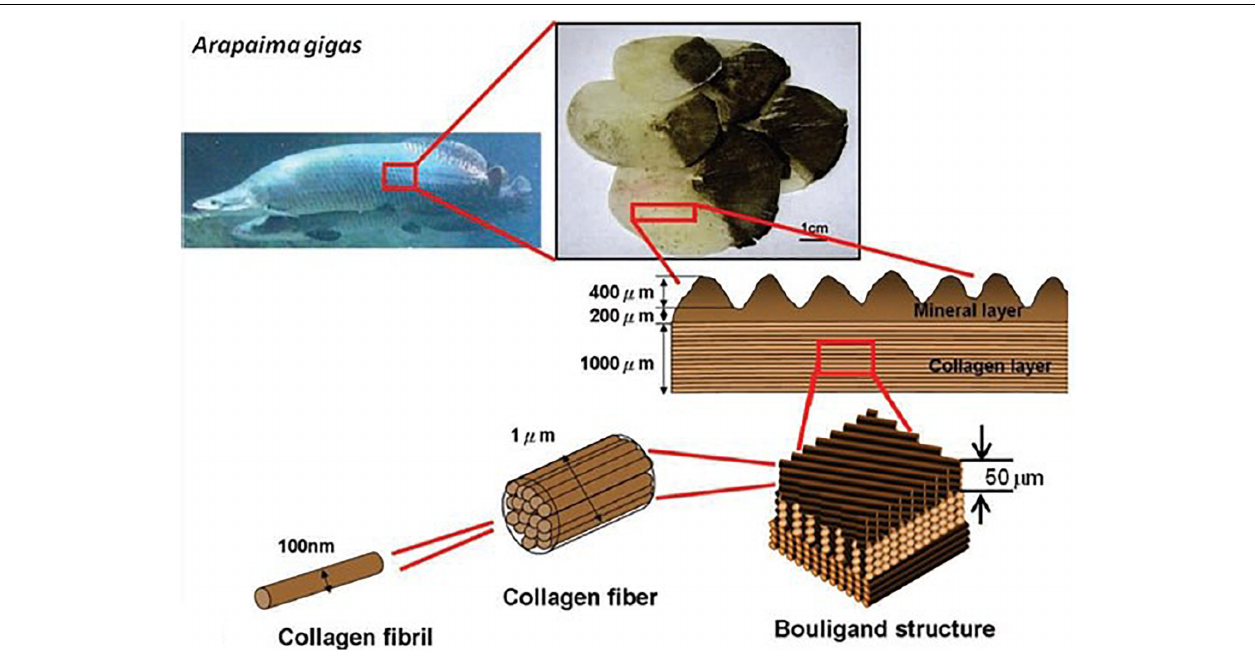
FIGURE 1 | Dermal armor for Arapaima gigas (Chen et al., 2012).